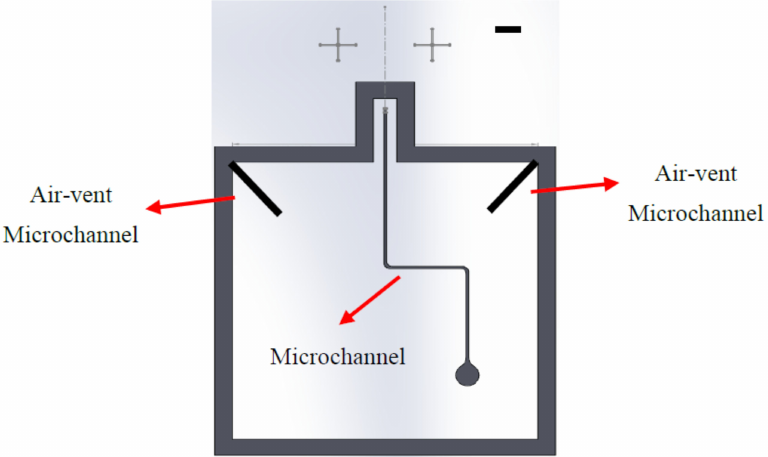
Figure 7. Schematic view of the microchannel layer of SPMF 3 with two air-vent microchannels.